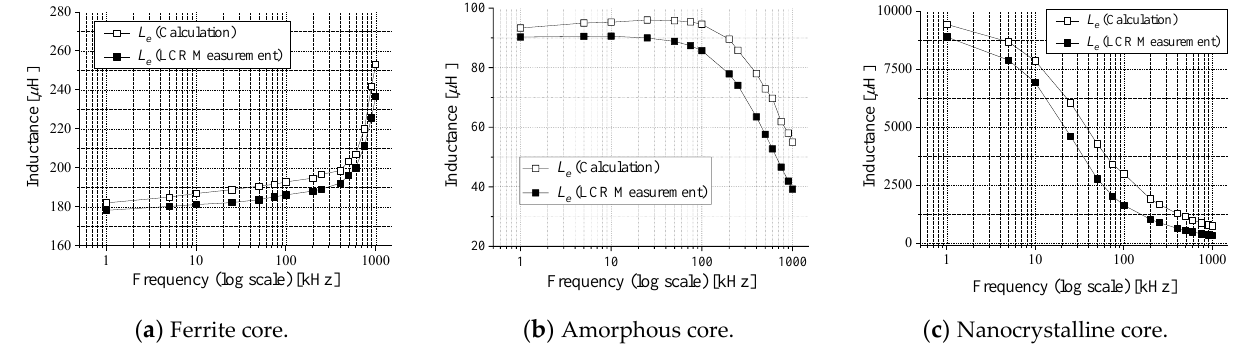
( b ) Amorphous core. ( c ) Nanocrystalline core. Figure 3. Calculated and LCR measurement results of the inductance for three different core materials.